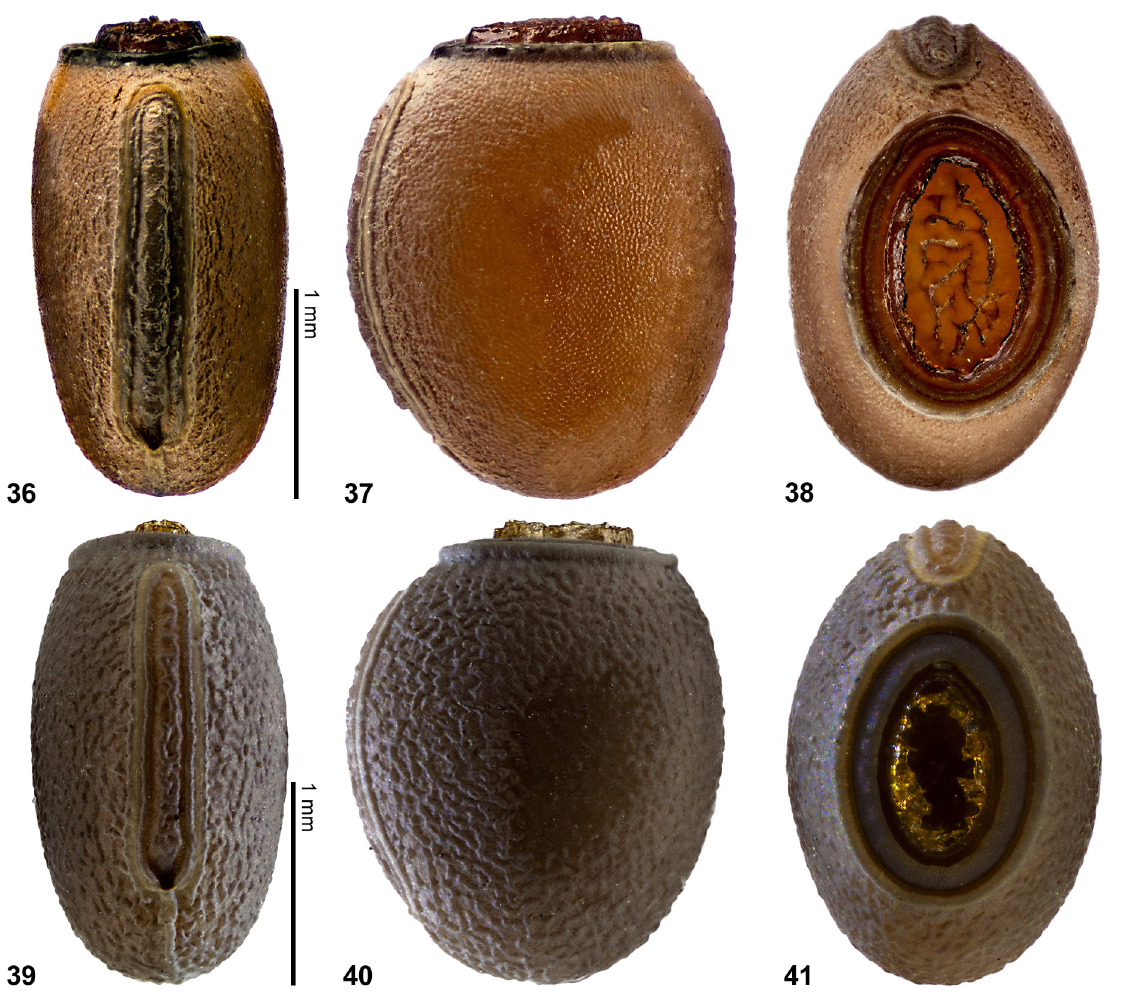
38 . Type A, anterior view. 39 . Type C, dorsal view. 40 . Type C, lateral view. 41 . Type C, anterior